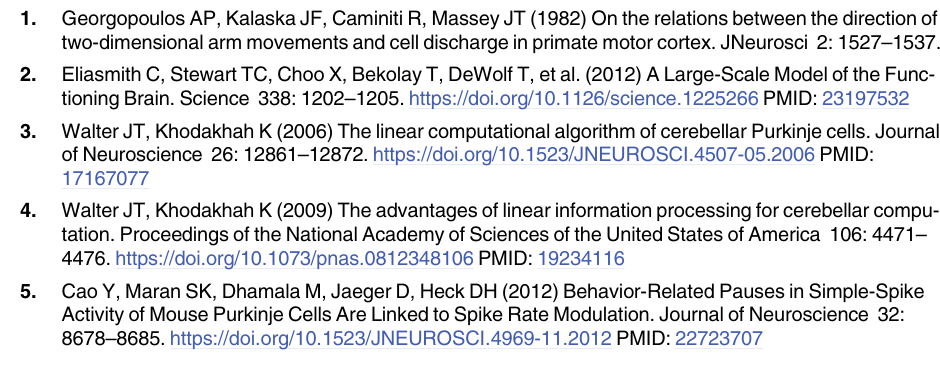
S9 Fig. Simulation outcomes for different amplitudes of slow and fast rate modulations in the PC master rate template. Gex = 3.5 nS, Gin = 16 nS, BMS = 0.8, BMF = 0.8 for all